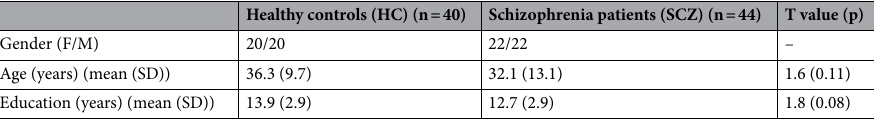
Table 1. Principal demographic characteristics of the studied